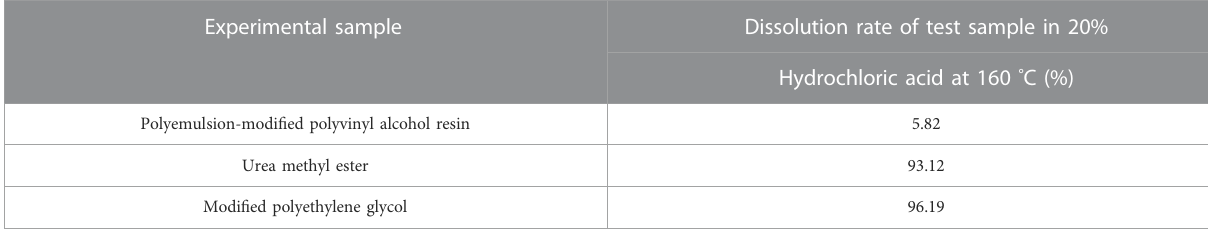
TABLE 1 Experiment on the solubility of the temporary plugging agents.